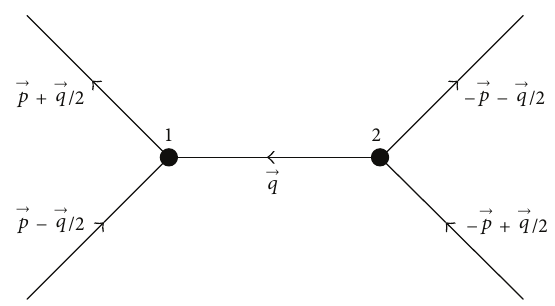
Figure 1: Momenta assignments for the tree-level interaction between sources/currents 1 and